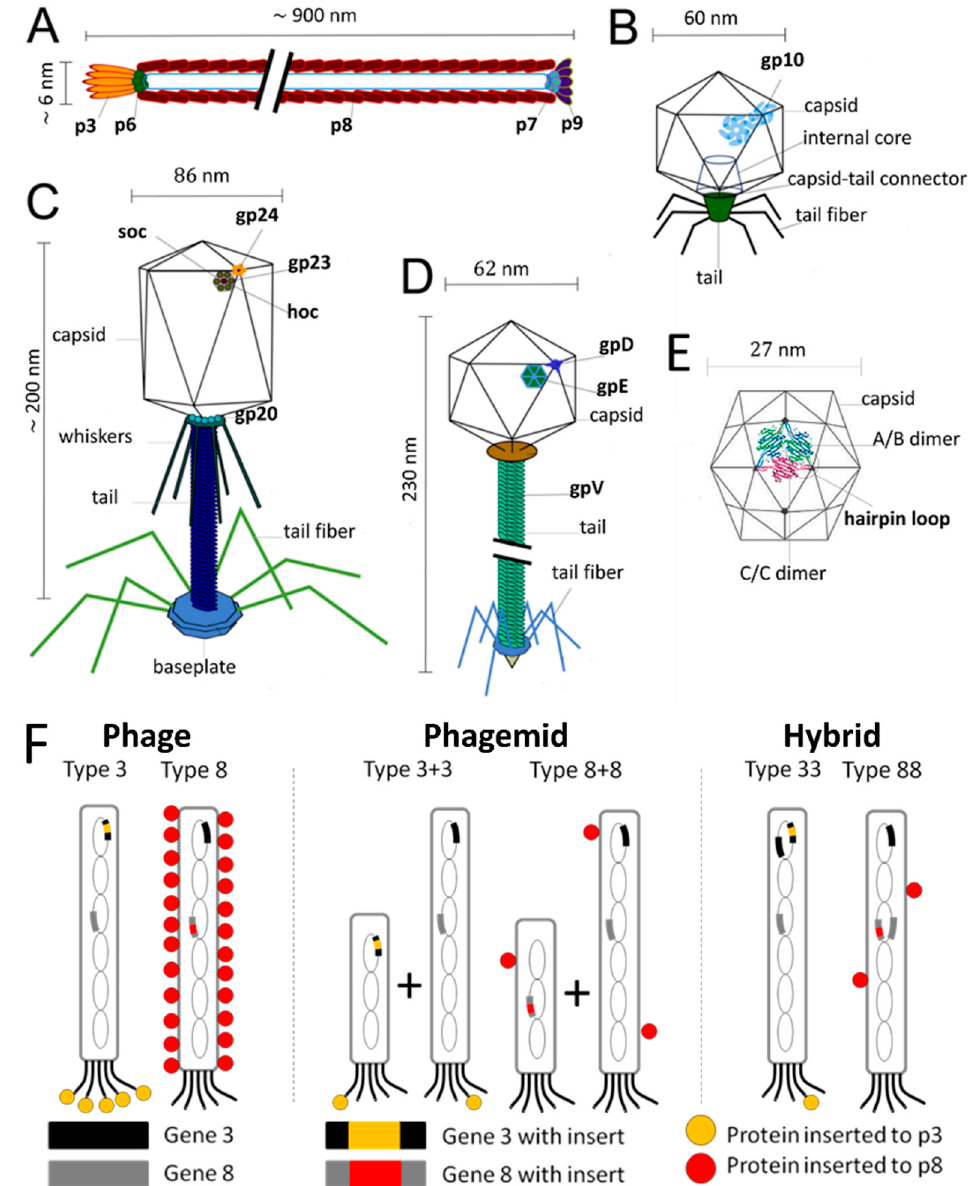
Figure 2. Assembly of coat proteins on bacteriophage ( A ) M13, ( B ) T7, ( C ) T4, ( D ) λ (lambda),